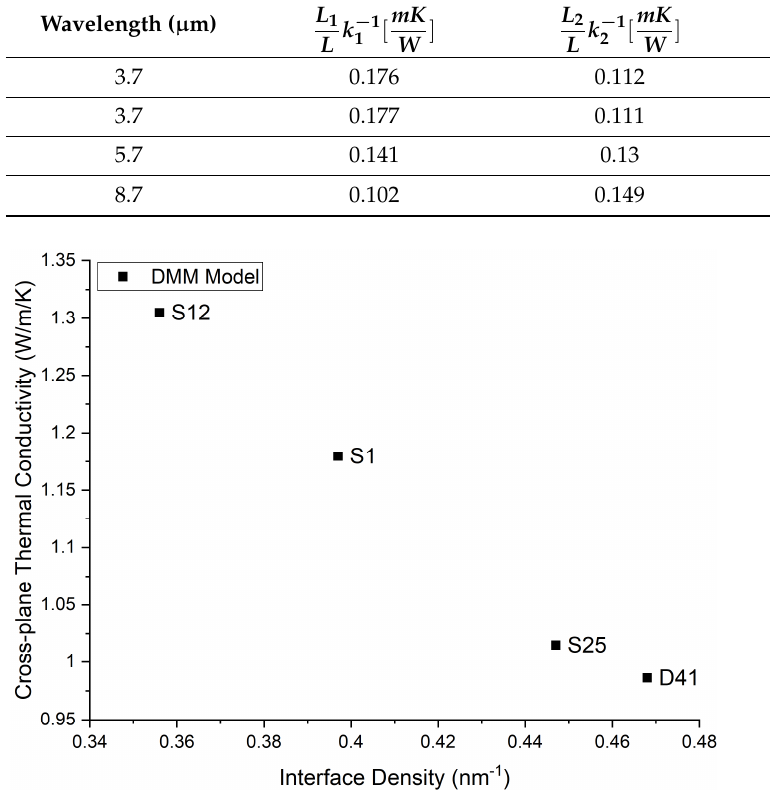
Figure 1. Theoretical relationship between interface density and thermal conductivity as per the